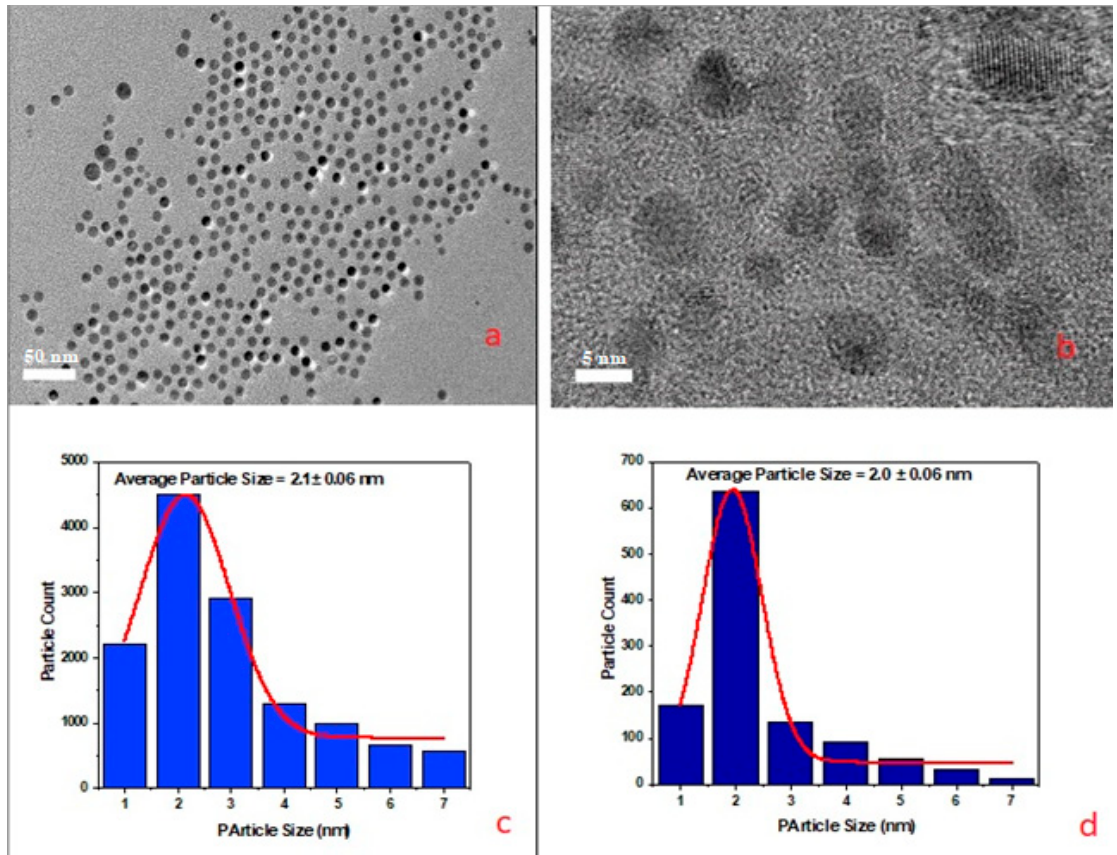
Figure 6. TEM images for ( a ) CDs-EDA and ( b ) CDs-L-Ph. Histogram showing particle size distribution for ( c ) CDs- and ( d ) CDs-L-Ph.